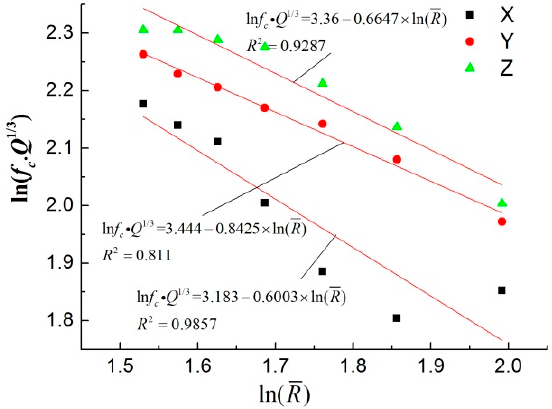
Figure 17. The f c of the pipe velocity spectrum.